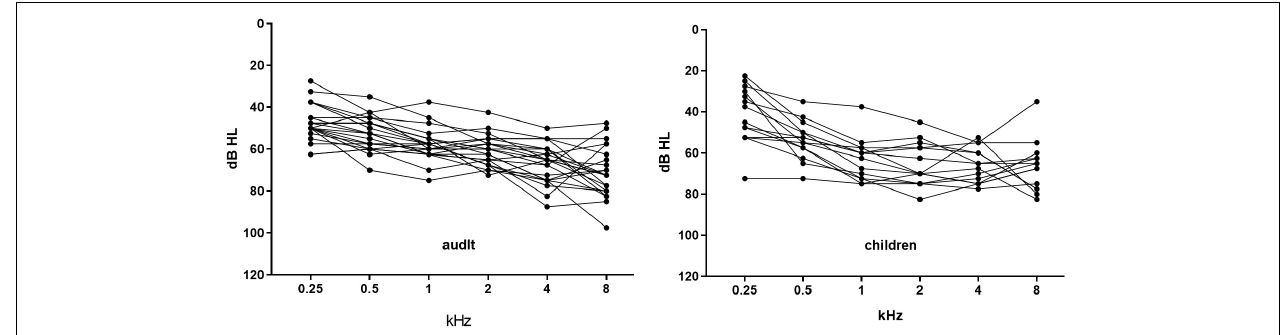
FIGURE 1 | The average hearing thresholds between the two ears of each individual adult and child. The horizontal axis represents the frequency. The vertical axis represents the hearing thresholds in dB HL. Each dot represents the average threshold of the left and right ears at this frequency of one individual.